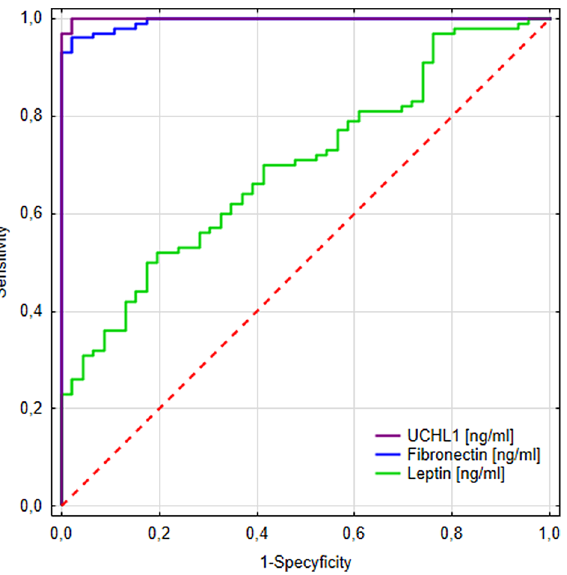
Figure 5. Areas under the ROC curves (AUCs) for plasma leptin, fibronectin, and UCHL1 evaluation in differentiating relapse-remitting multiple sclerosis patients from healthy individuals. For plasma leptin the AUC = 0.698, cut-off = 14.49 ng/ml; for plasma fibronectin the AUC = 0.994, cut-off = 0.94 ng/ml; for plasma UCHL1 the AUC = 0.999, cut-off = 7.63